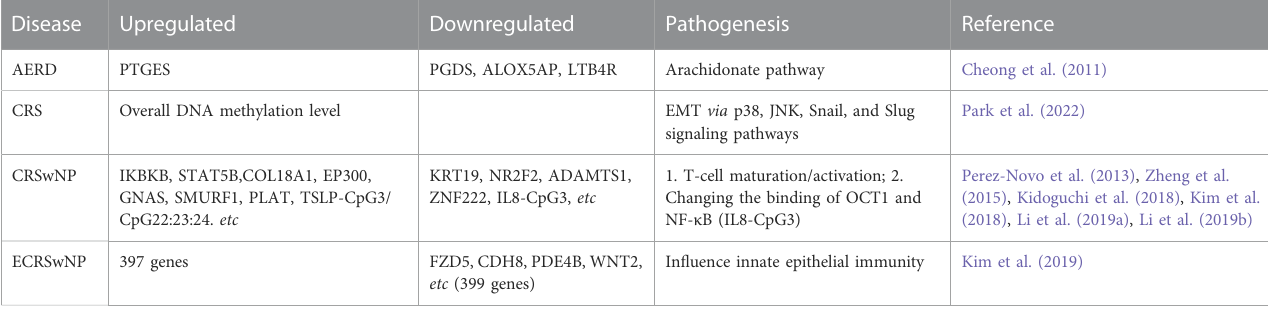
TABLE 1 DNA methylation involved in chronic